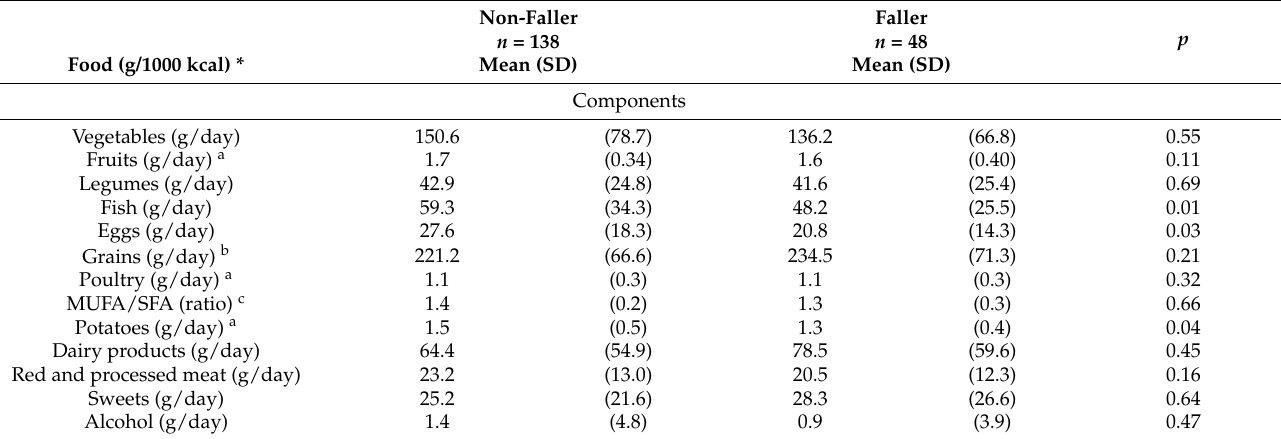
Table 2. Association of jMD food group components with